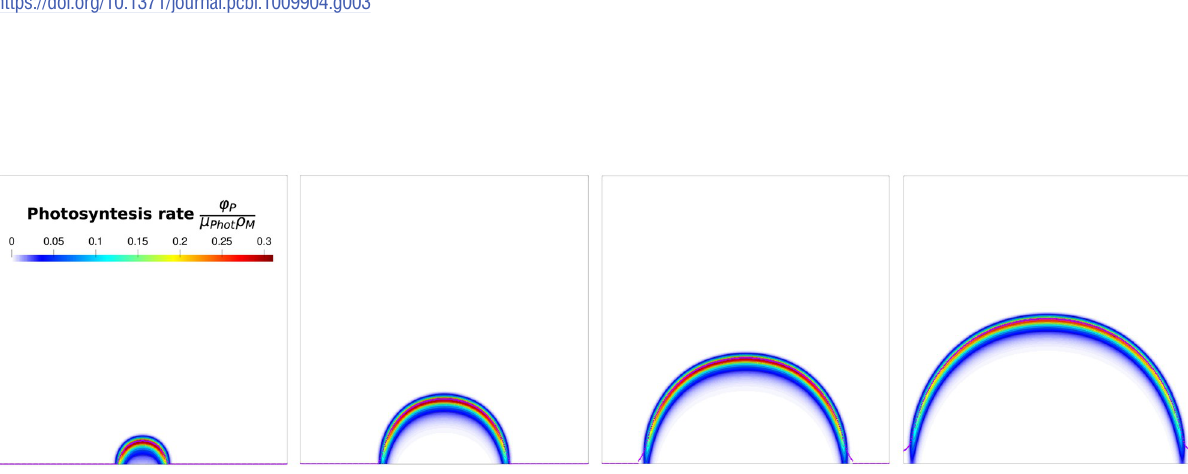
PLOS Computational Biology | https://doi.org/10.1371/journal.pcbi.1009904 April 4, 2022 8 /